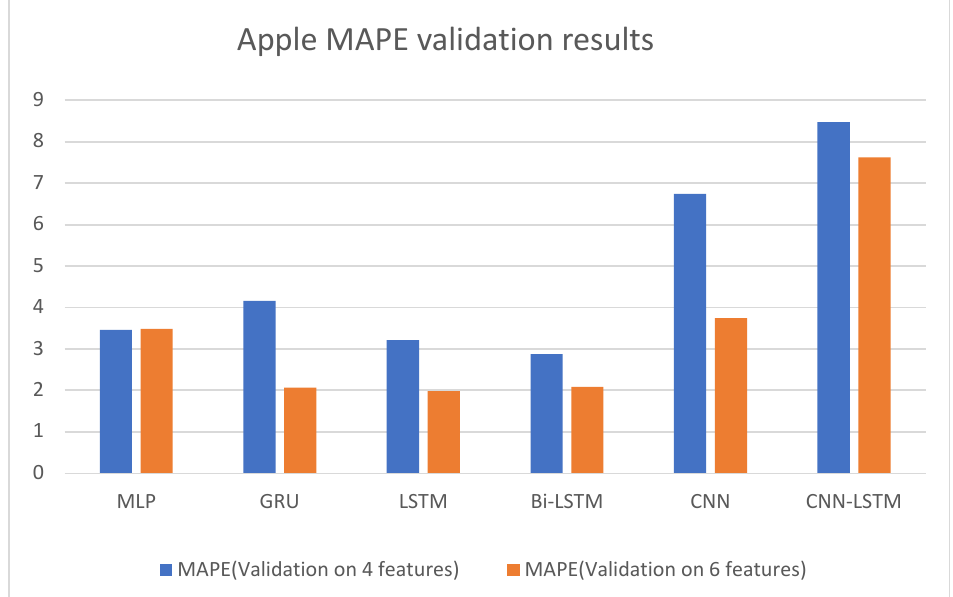
Figure 6. The visualization of the MAPE results for Apple .